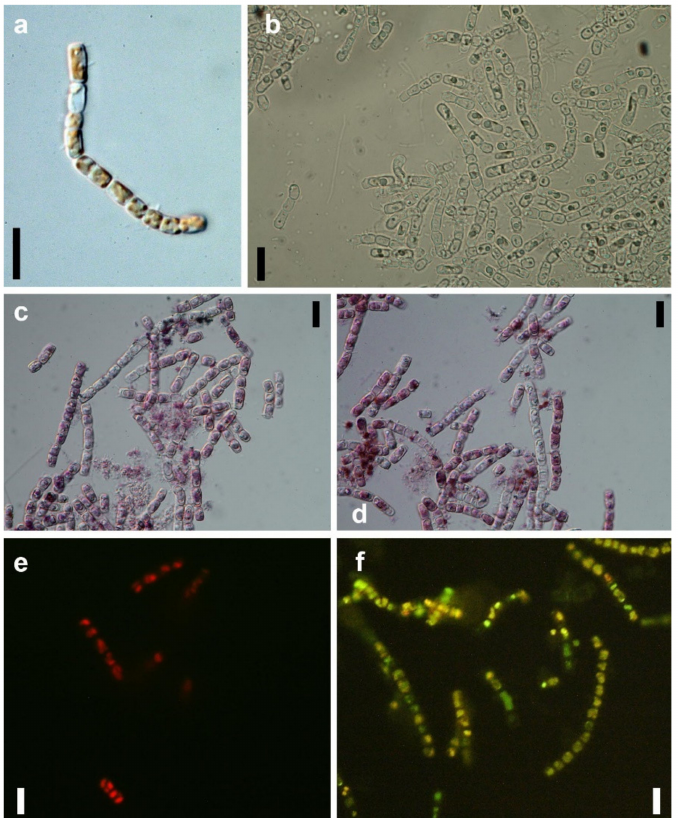
Figure 1. Images of a control ( a ) and gold-treated N. shiloi captured after 30 min ( b ), 24 h ( c ) and 72 h ( d ) of the reaction with HAuCl 4 . Fluorescent images of control ( e ) and GNP-loaded ( f ) N. shiloi captured in the blue light region (~450–490 nm) (Scale bars 10 µ m). Table 1. The reaction time of GNP formation in different concentrations and pH combinations of the Au 3+ solution. Reducing